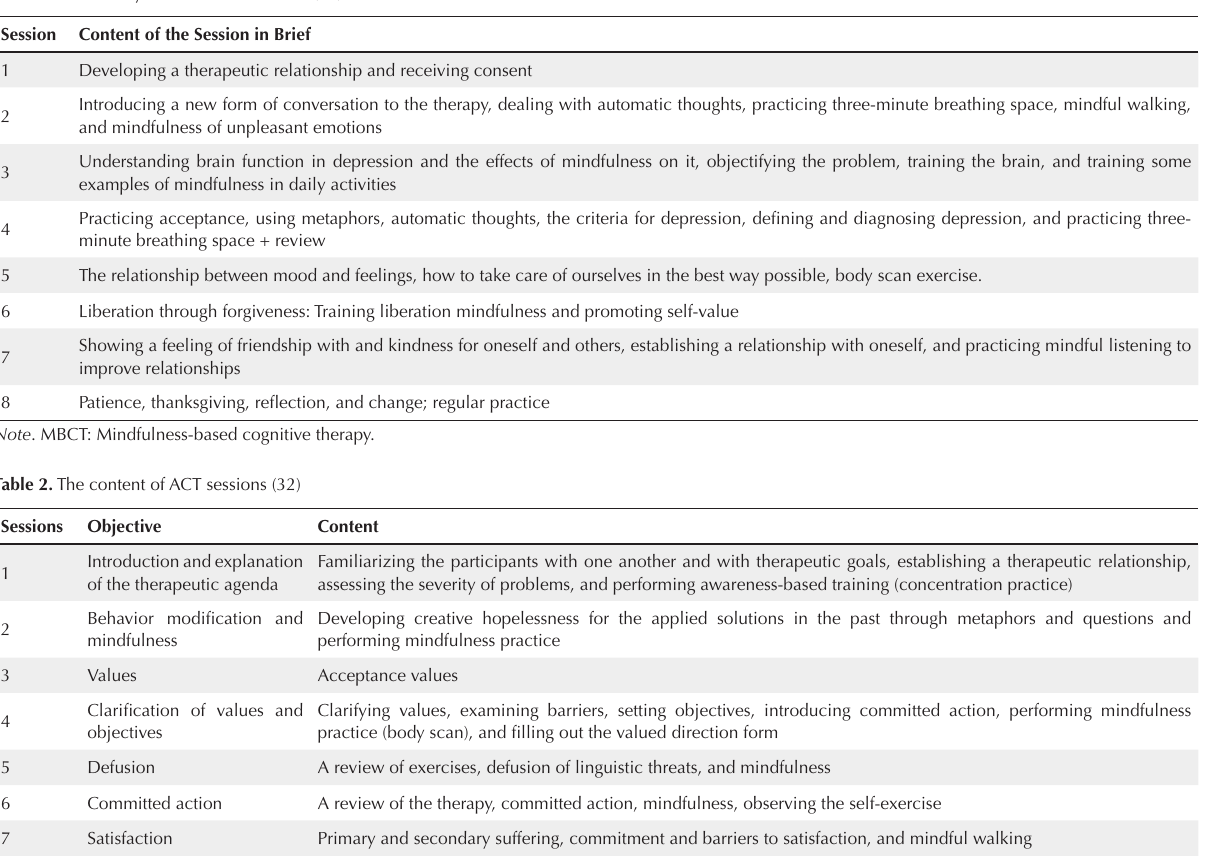
Table 1. A summary of the MBCT sessions